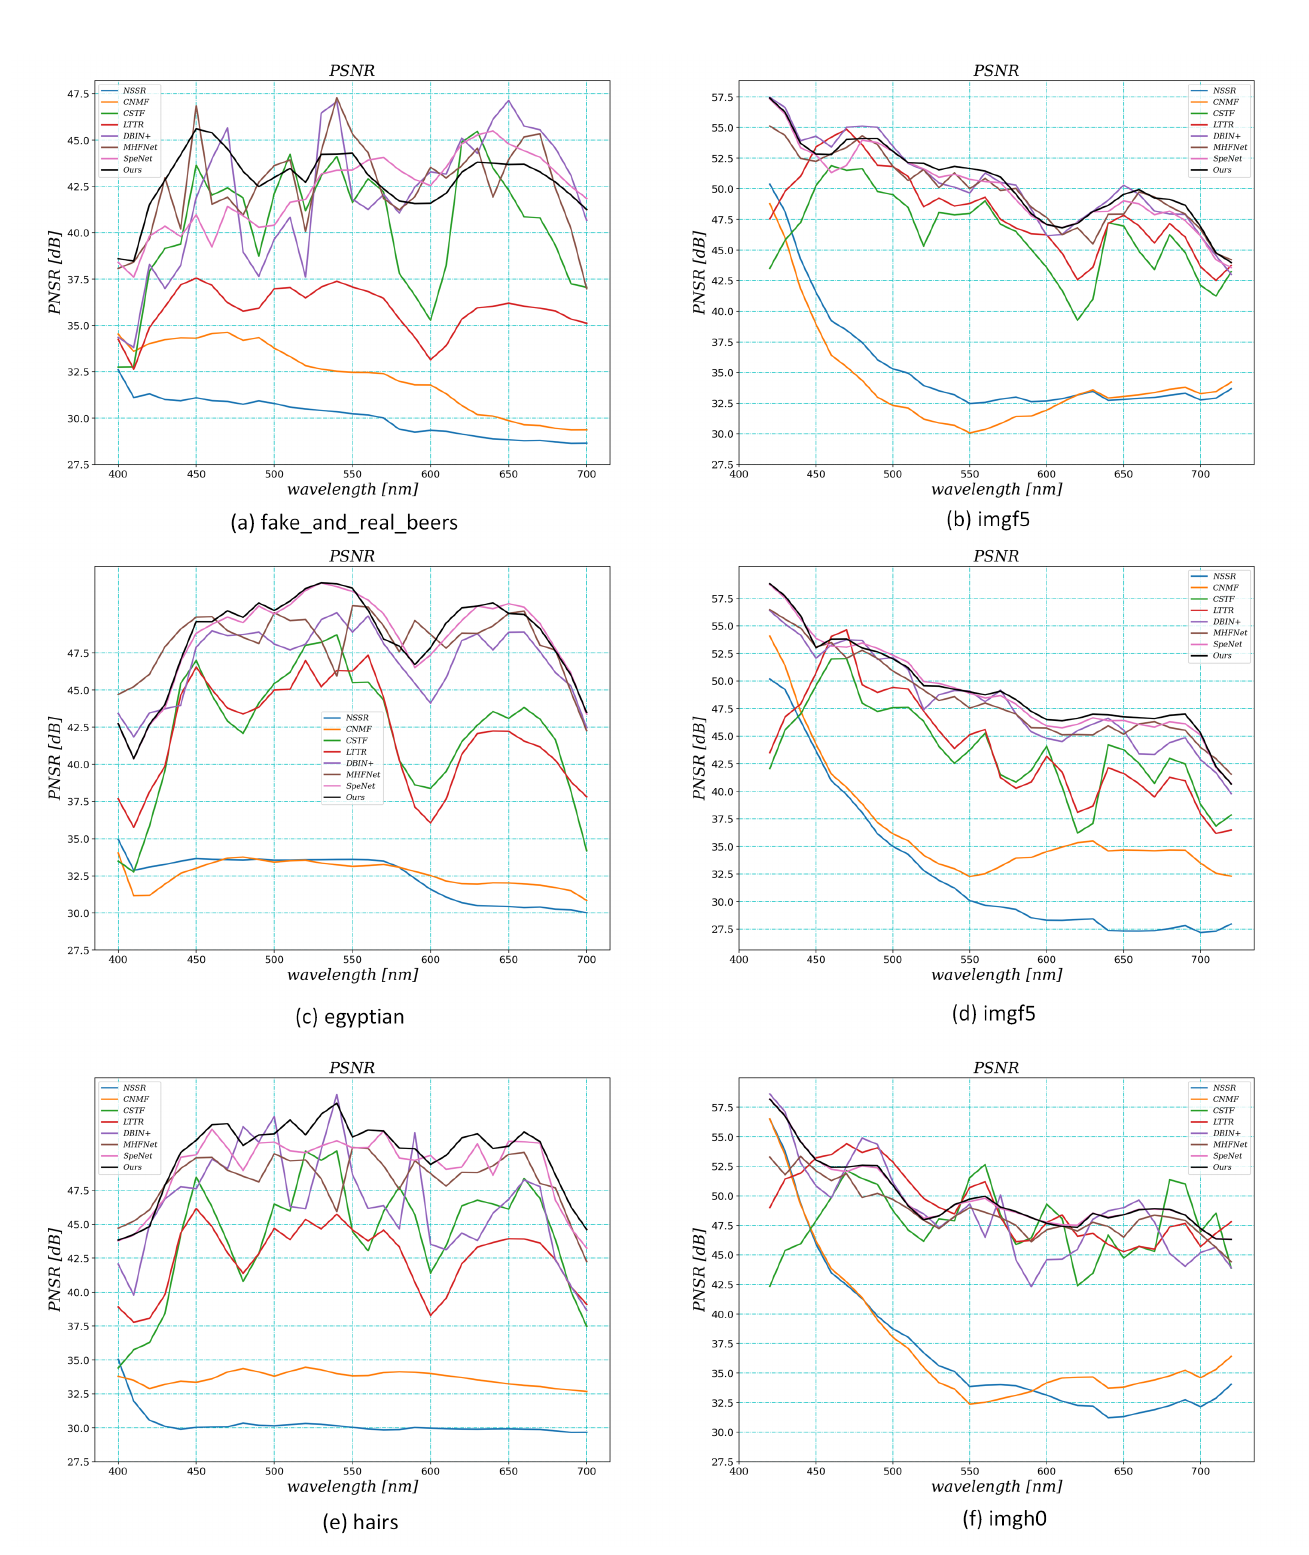
Figure 8. Compare PSNR values for each spectral band of the reconstructed HR-HSI. ( a , c , e ) represent the data of the three groups of images in the CAVE dataset; ( b , d , f ) represent the data of the three groups of images in the HARVARD